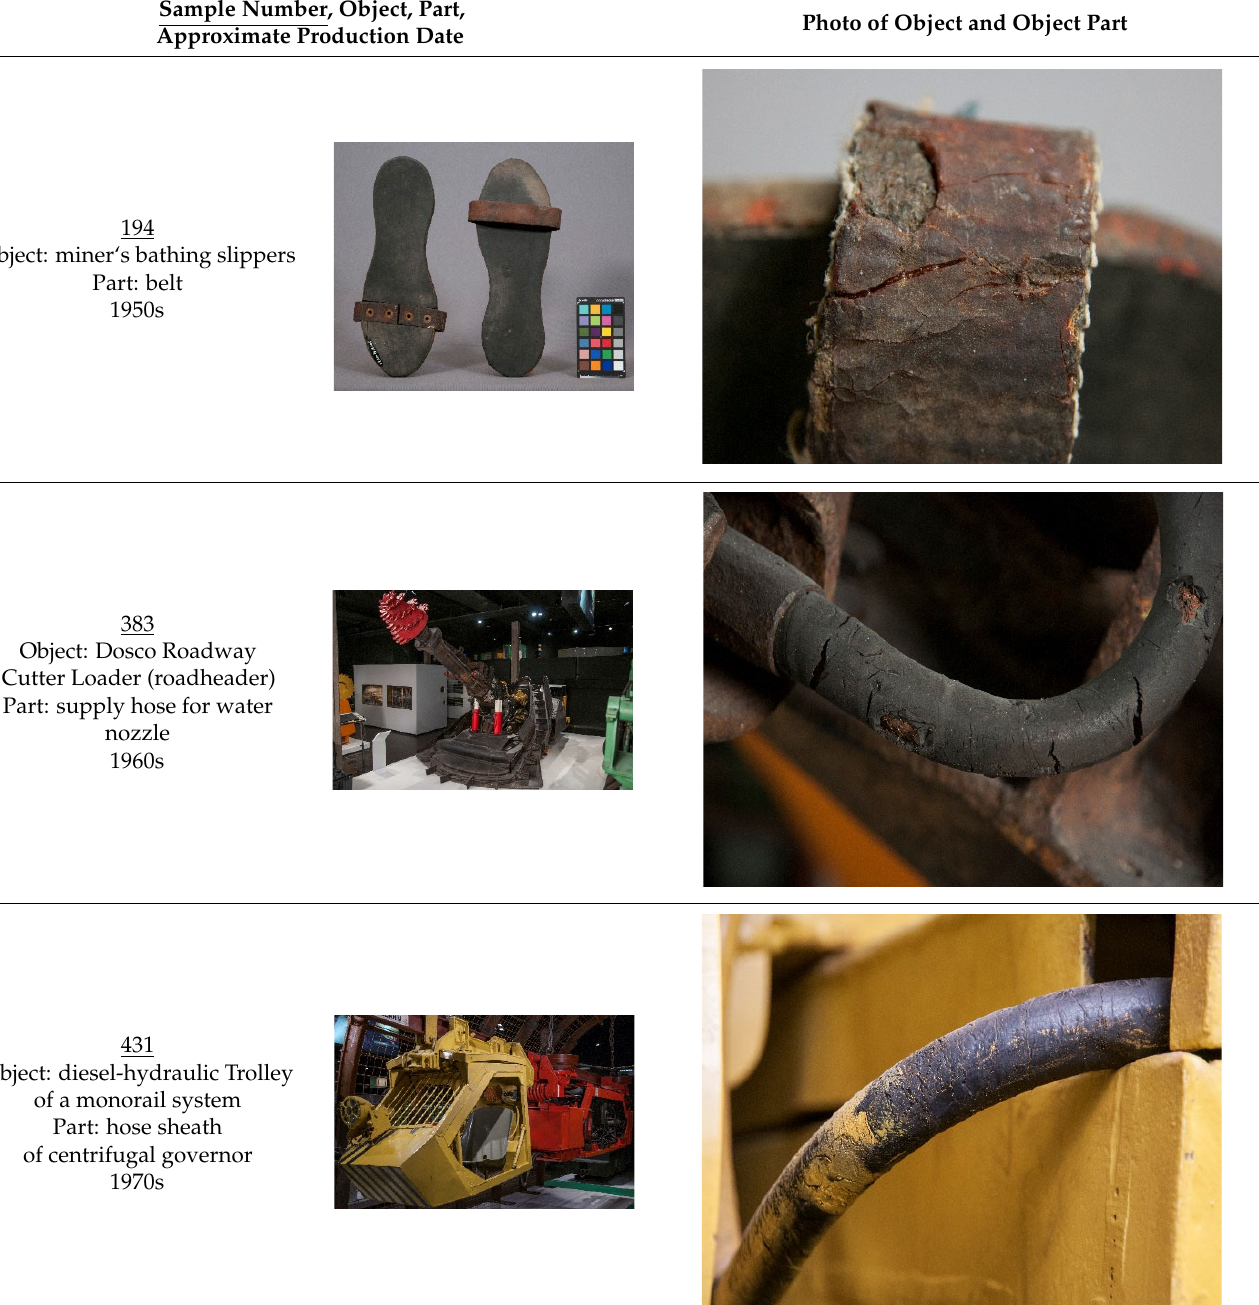
and pyrolysis ‐ GCMS (py ‐ GCMS) data, with the purpose of identifying their main compo ‐ nents. Table 9. Overview of some rubber objects found during the survey. The numbering used for the samples during the survey are also used here as the ‘sample number’ for orientation throughout the text.